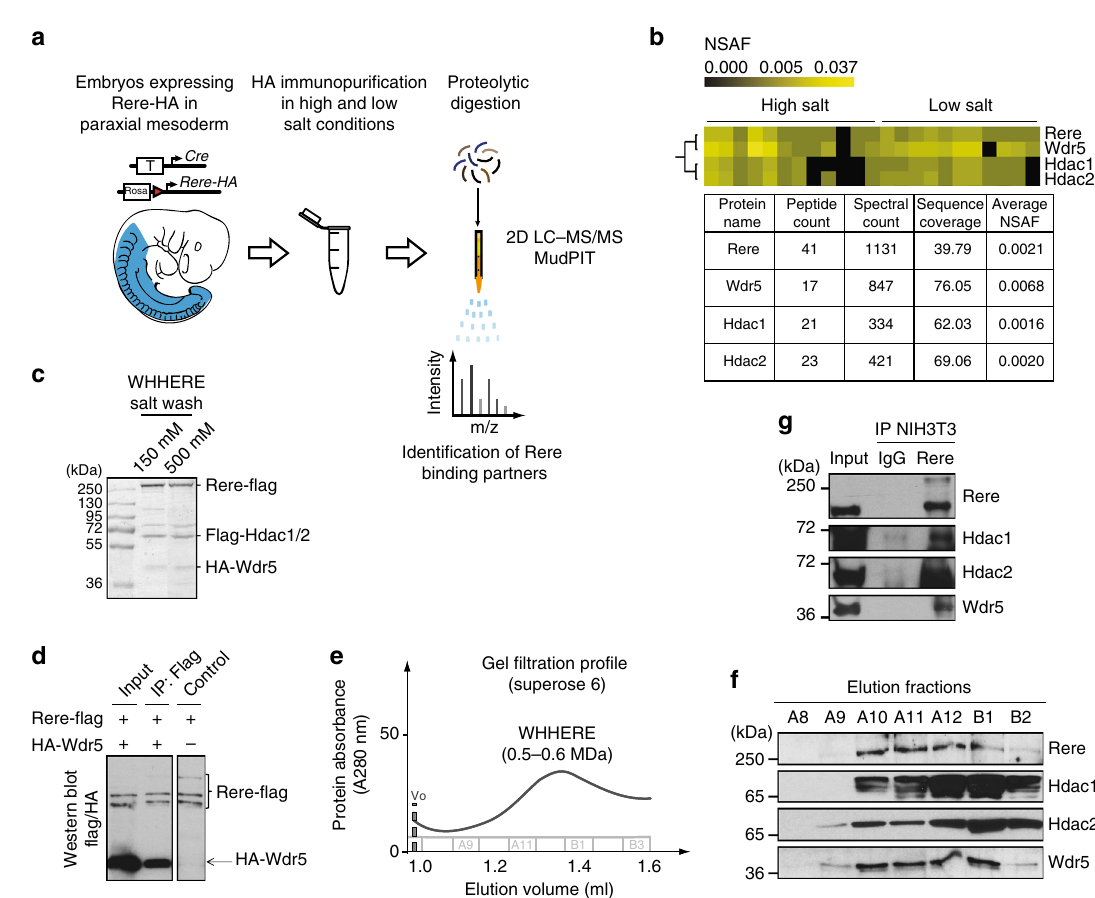
Fig. 1 Proteomic identi fi cation of the WHHERE protein complex containing Wdr5, Hdac1, Hdac2, and Rere. a Schematic work fl ow for the proteomic strategy used to identify Rere-associated proteins. b Hierarchical clustering of the NSAF values showing Wdr5, Hdac1, and Hdac2 clustering with Rere identi fi ed by MudPIT. Columns correspond to different immunoprecipitations conditions. Table showing the peptide count, spectral count, sequence coverage (%) and average NSAF values for Rere, Wdr5, Hdac1, and Hdac2. c SDS-PAGE gel stained with Coomassie blue after Flag immunopuri fi cation at low (150 mM KCl) and high (500 mM KCl) salt wash of the recombinant WHHERE complex from baculoviruses infected cells co-expressing Rere-Flag, Flag-Hdac1, Flag-Hdac2, and HA-Wdr5. Identi fi cation of the different components was con fi rmed by LC – MS/MS analysis of the corresponding gel bands. d Flag immunoprecipitation from extracts of cells infected with baculoviruses expressing HA-Wdr5 and Rere-Flag. Flag and HA western blot. The three bands recognized by the anti-Flag antibodies correspond to Rere and its degradation products. e Gel fi ltration chromatography pro fi le of the WHHERE complex puri fi ed from baculoviruses infected cells co-expressing Rere-Flag, Flag-Hdac1, Flag-Hdac2, and HA-Wdr5. f Immunoblot analysis for Rere, Hdac1, Hdac2, and Wdr5 showing the gel fi ltration chromatography elution fractions from A8 to B2. g Rere immunoprecipitation from NIH3T3 cells identifying the endogenous WHHERE complex components. Rere, Hdac1, Hdac2, and Wdr5 were detected after western blot analysis of Rere immunoprecipitation eluates and compared to a negative control immunoprecipitation (IgG) and